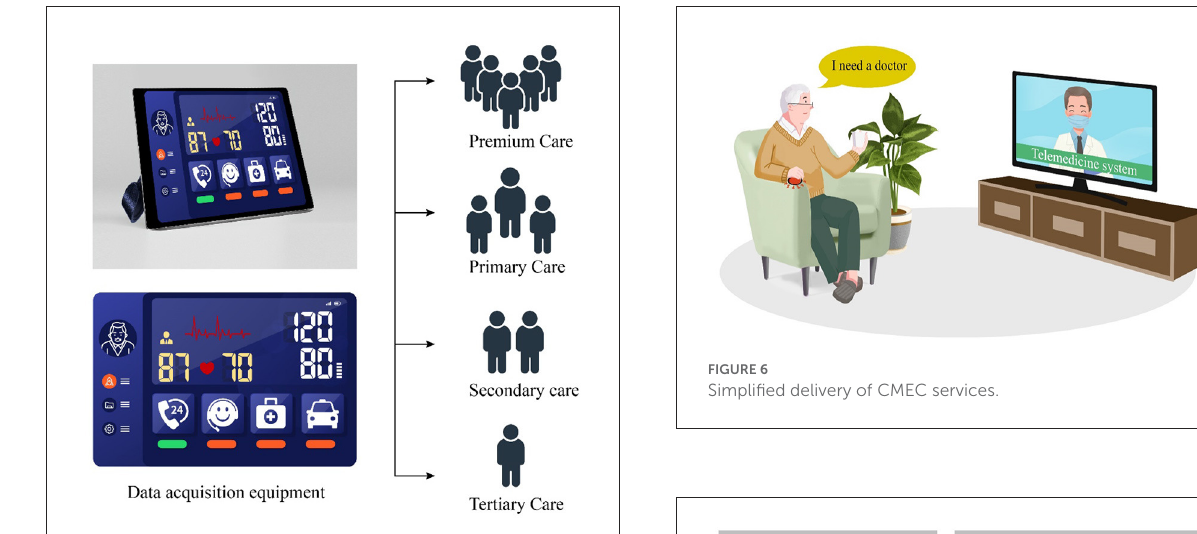
FIGURE4 Differential classification of CMEC services.